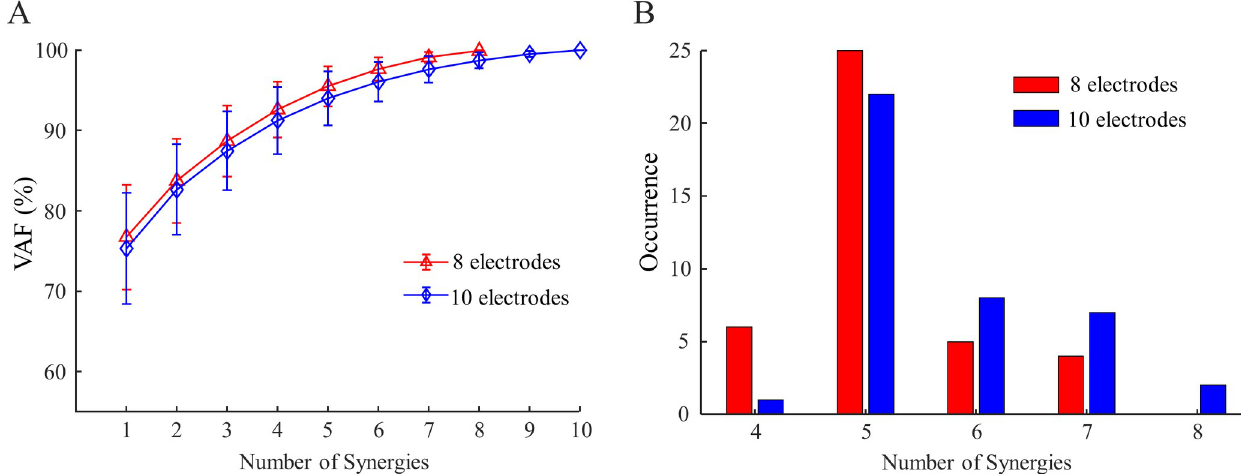
Fig 1. Dimensionality estimation of forearm muscle activation in able-bodied subjects. (A) EMG data variance explained (VAF) by synergies extracted from able-bodied subjects, plotted as electrode count increased. (B) Histogram distribution of the number of synergies extracted from all forty able-bodied